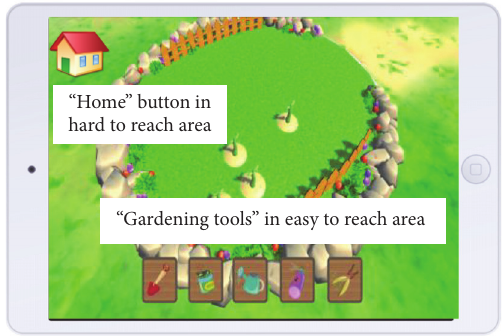
Figure 3: Graphical usages of mobile UI in landscape view.